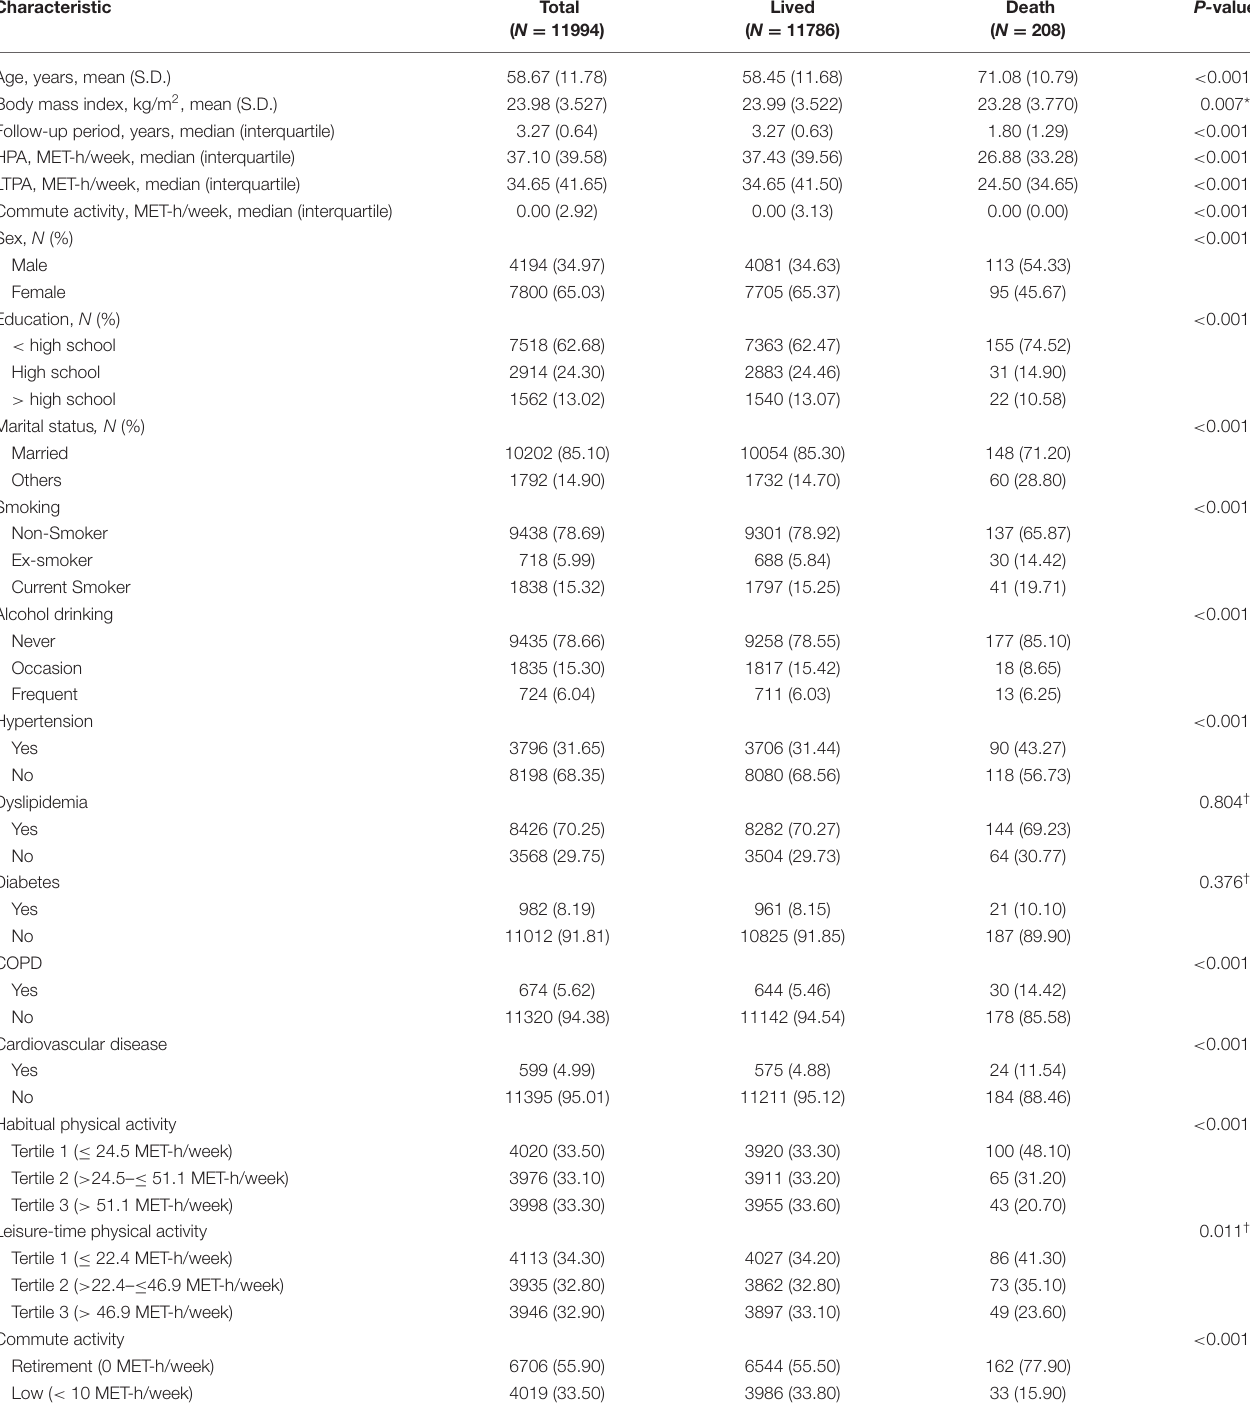
TABLE 1 | The characteristics of